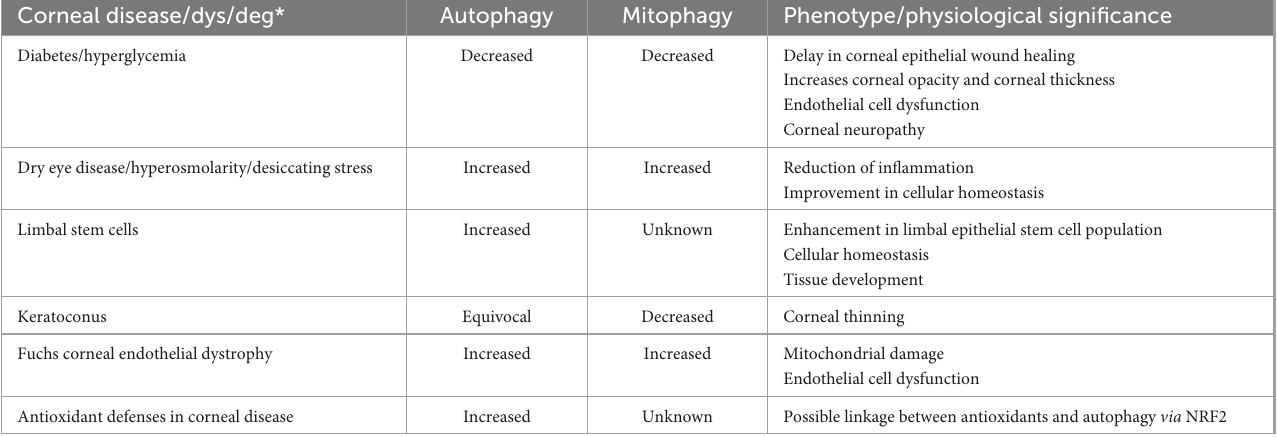
TABLE 1 The role of autophagy/mitophagy in corneal diseases, dystrophies, and degenerations. Corneal